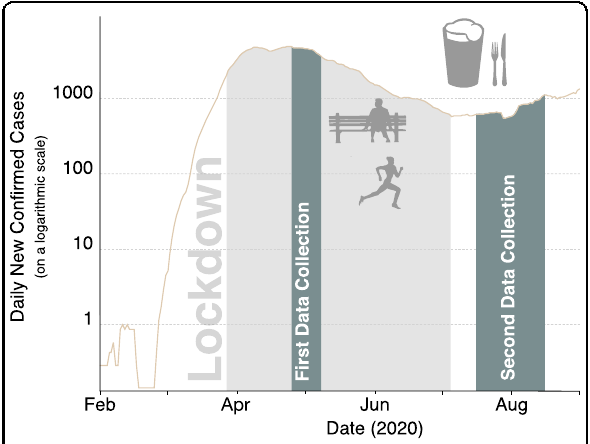
Fig. 1 Longitudinal data collection of mental health symptoms. The fi rst data collection took place from the 24th of April to the 7th of May. Shown is the log-average of daily new con fi rmed Covid-19 cases, using the rolling 7-day average in the UK from the 1st of February 2020 to the 1st of September 2020. Lockdown was formally enforced on the 26th of March. The ease of lockdown commenced on the 10th of May when people were encouraged to visit parks again and engage in unlimited outdoor exercise. On the 4th of July pubs and restaurants were among the last businesses to come out of lockdown. The second data collection took place from the 15th of July until the 15th of August, after the lockdown restrictions had been lifted. The pandemic curve has been plotted on the basis of data maintained by Our World in Data 63